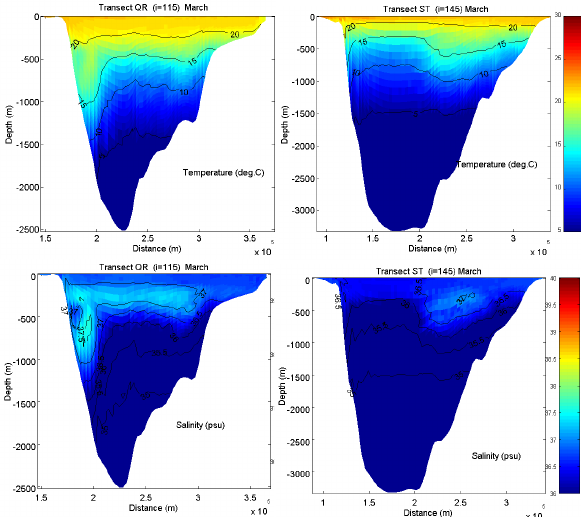
Fig. 20. The mean monthly temperature and salinity along QR and ST cross sections (see Fig. 5) in